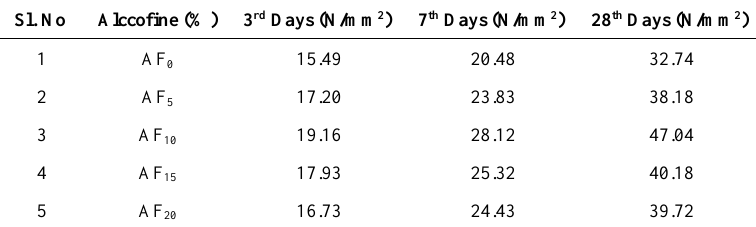
Table 10. Compressive strength test for mortar cube (PPC AF ES).